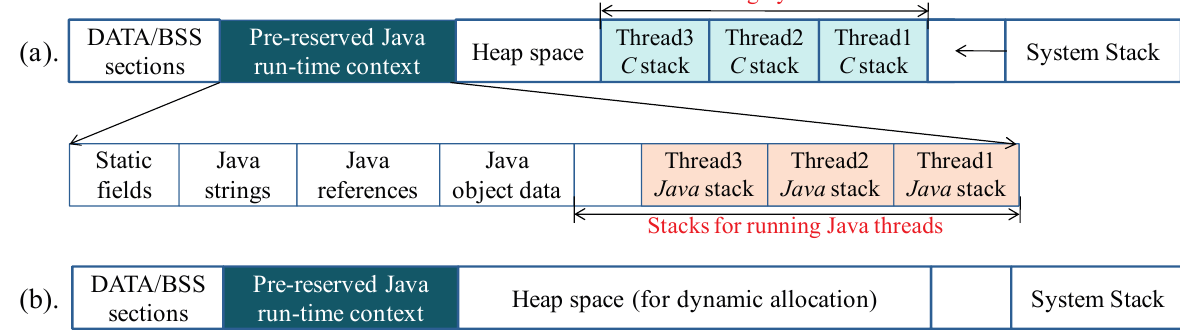
Figure 4. ( a ) If the Java thread can preempt each other at any time, each C-programmed byte code handler needs to have an independent run-time stack; ( b ) After the cooperative threading mechanism is used, byte code handlers will not be preempted during the mid-executing process. Consequently, no independent C run-time stack needs to be pre-reserved for each